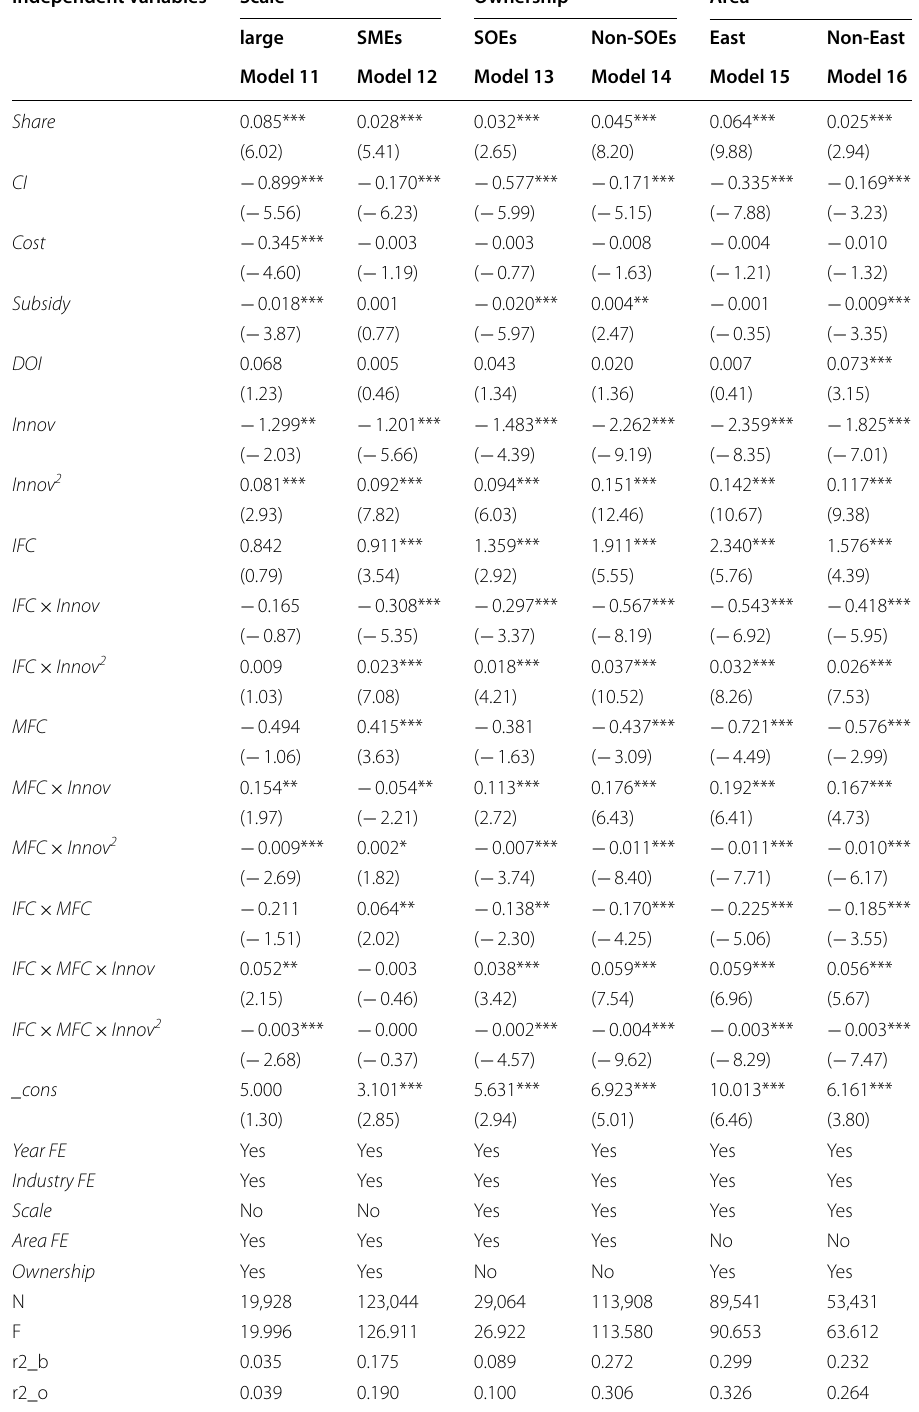
Table 6 Subgroup regression results of firms under different ownership and different